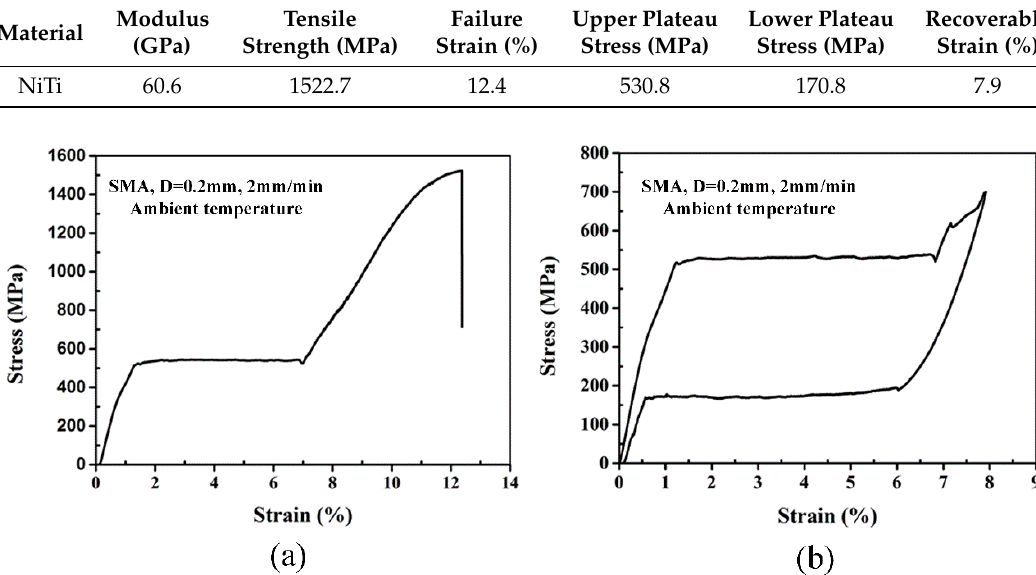
Figure 1. Tensile stress-strain curves of superelastic SMA wires (( a ) Representative stress/strain curve of the tensile tests, ( b ) superelastic deformation of the SMA wire).